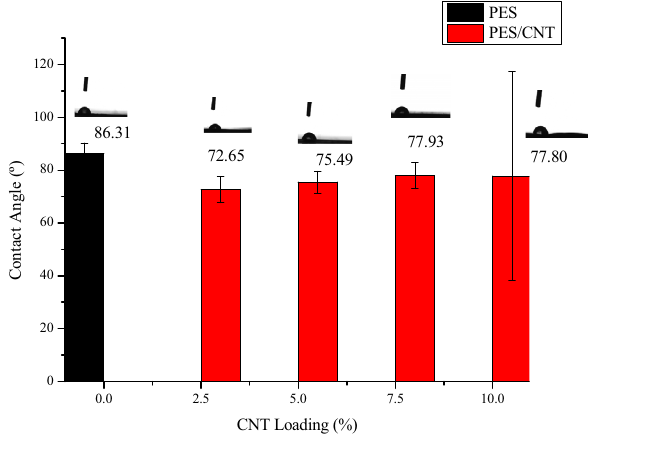
Figure 6. Contact angle